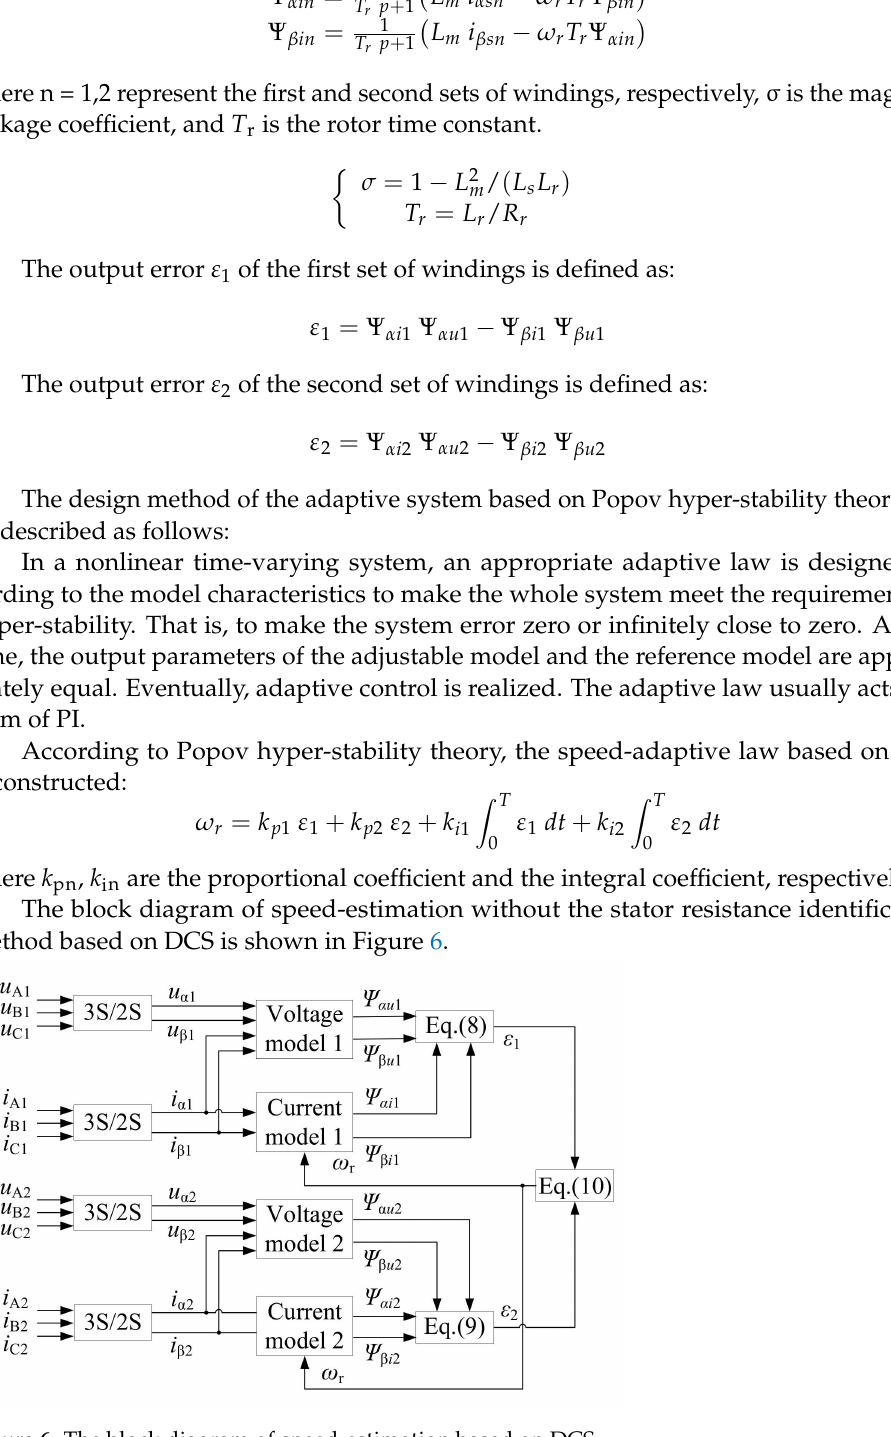
Figure 6. The block diagram of speed-estimation based on